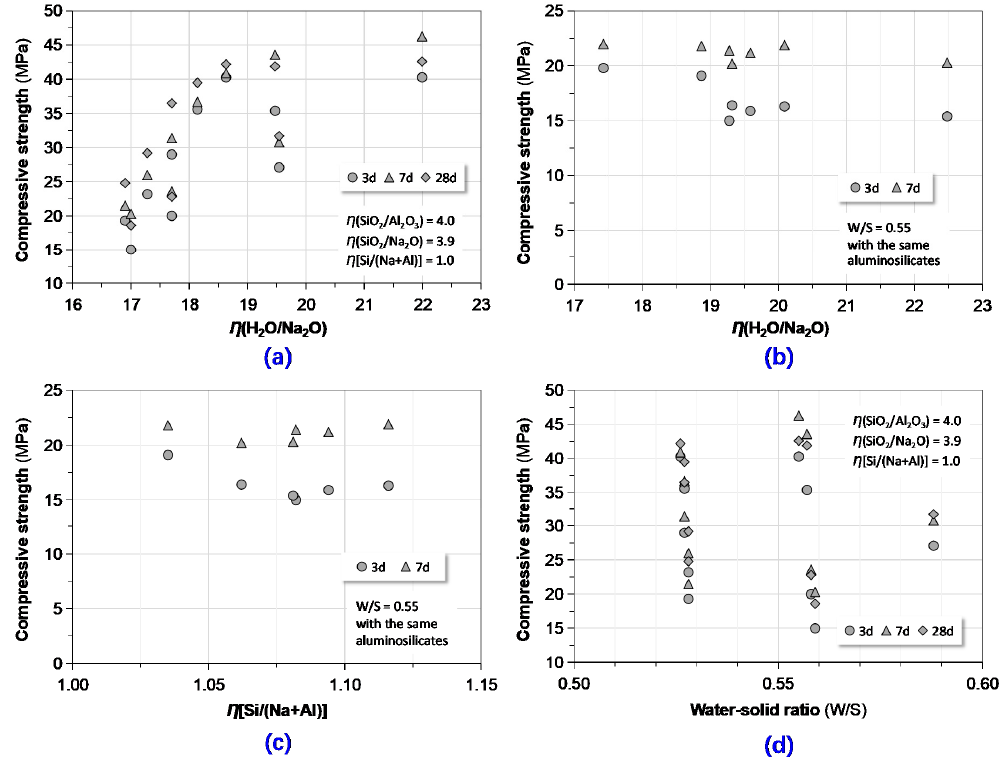
Figure 10. Correlating compressive strength to key molar ratios and W/S: ( a ) and ( b ) compressive strength vs. η (SiO 2 /Na 2 O); ( c ) compressive strength vs. η [Si/(Na+Al)]; and ( d ) compressive strength vs. W/S.